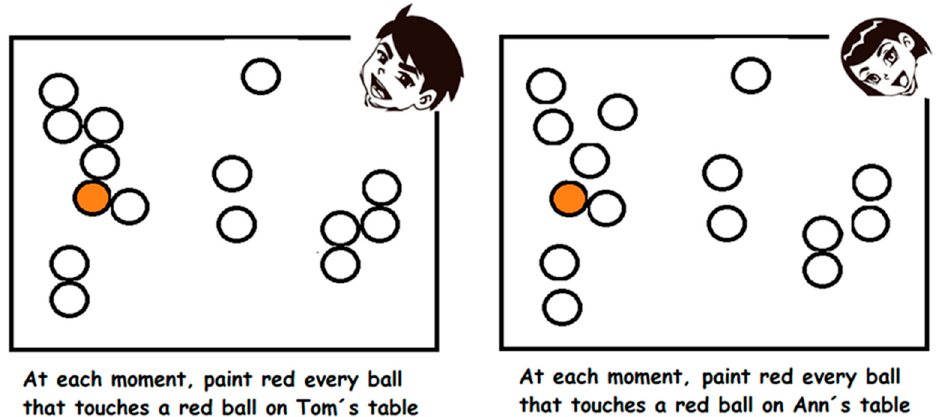
Figure 3. A coloring activity with a recursive painting instruction, where contagion in a ball is simulated by painting it red, as in (NHK, 2020) experiment.